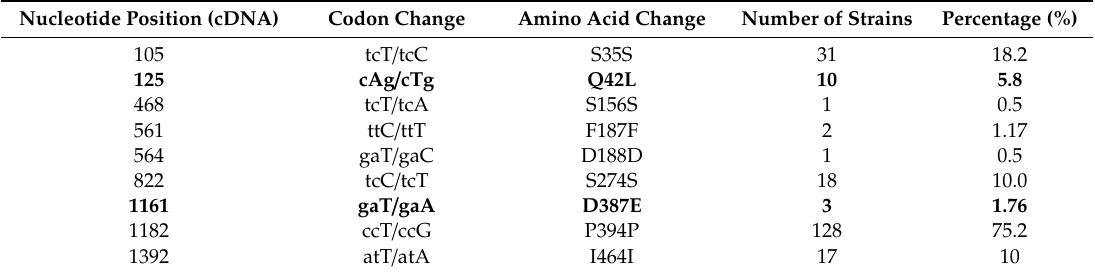
Table 4. Analysis of the cyp51B polymorphisms and Cyp51B amino acid substitutions found in our set of 170 A. fumigatus clinical strains. Bold letters indicate amino acid changes.